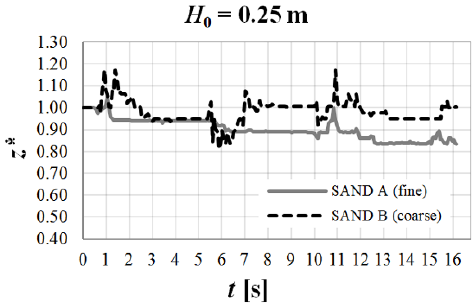
Figure 6. Experimental time evolution of z * at the dike upstream reference abscissa ( −δ ) for Tests A2 and B2.